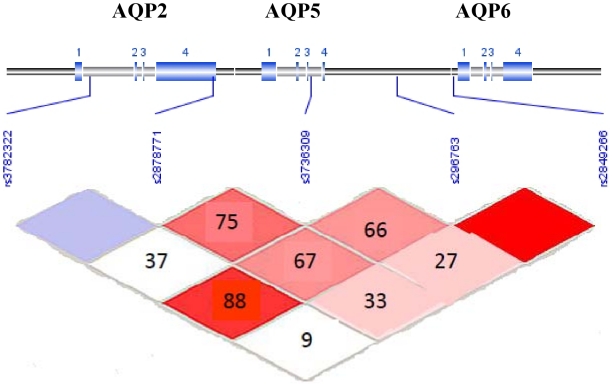
Linkage Disequilibrium for 5 SNPs in the AQP5 Gene in European American participants with COPD.Pairwise LD in subjects is represented as red squares for strong LD, blue squares for non-significant LD, and white squares for little or no LD. LD blocks are identified as noted.